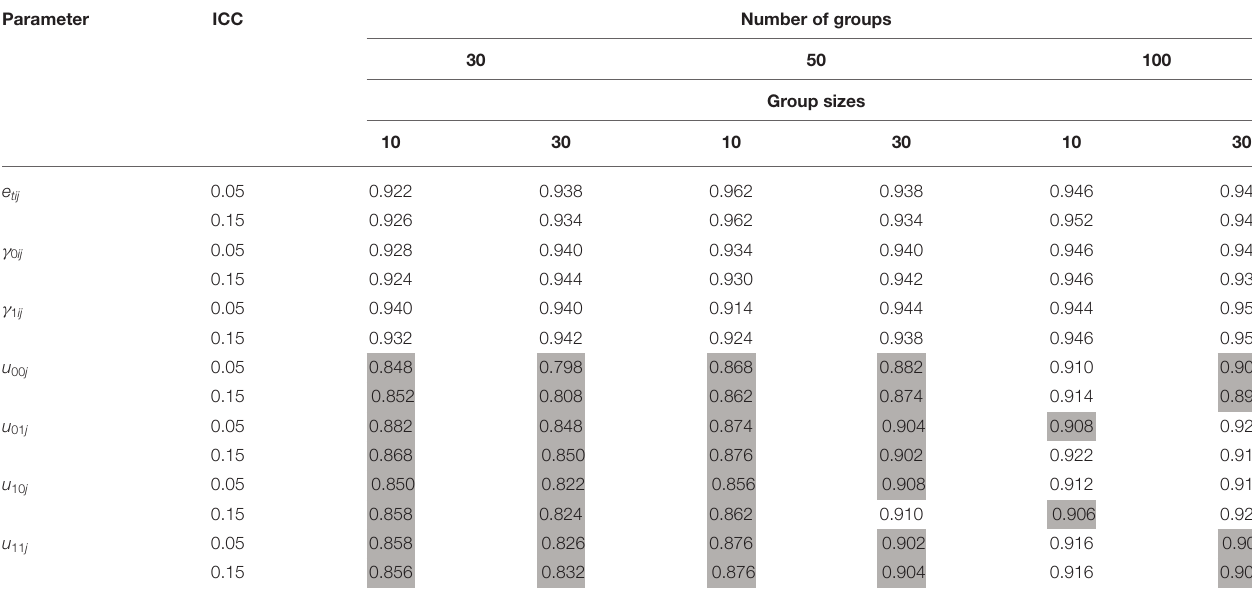
The shaded cells indicate meaningfully biased values.